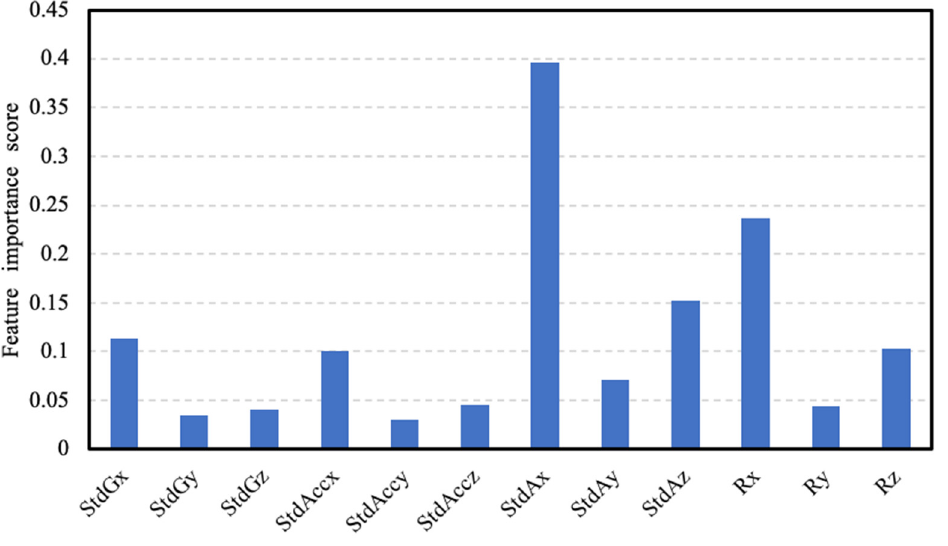
Figure 11. The feature importance scores.